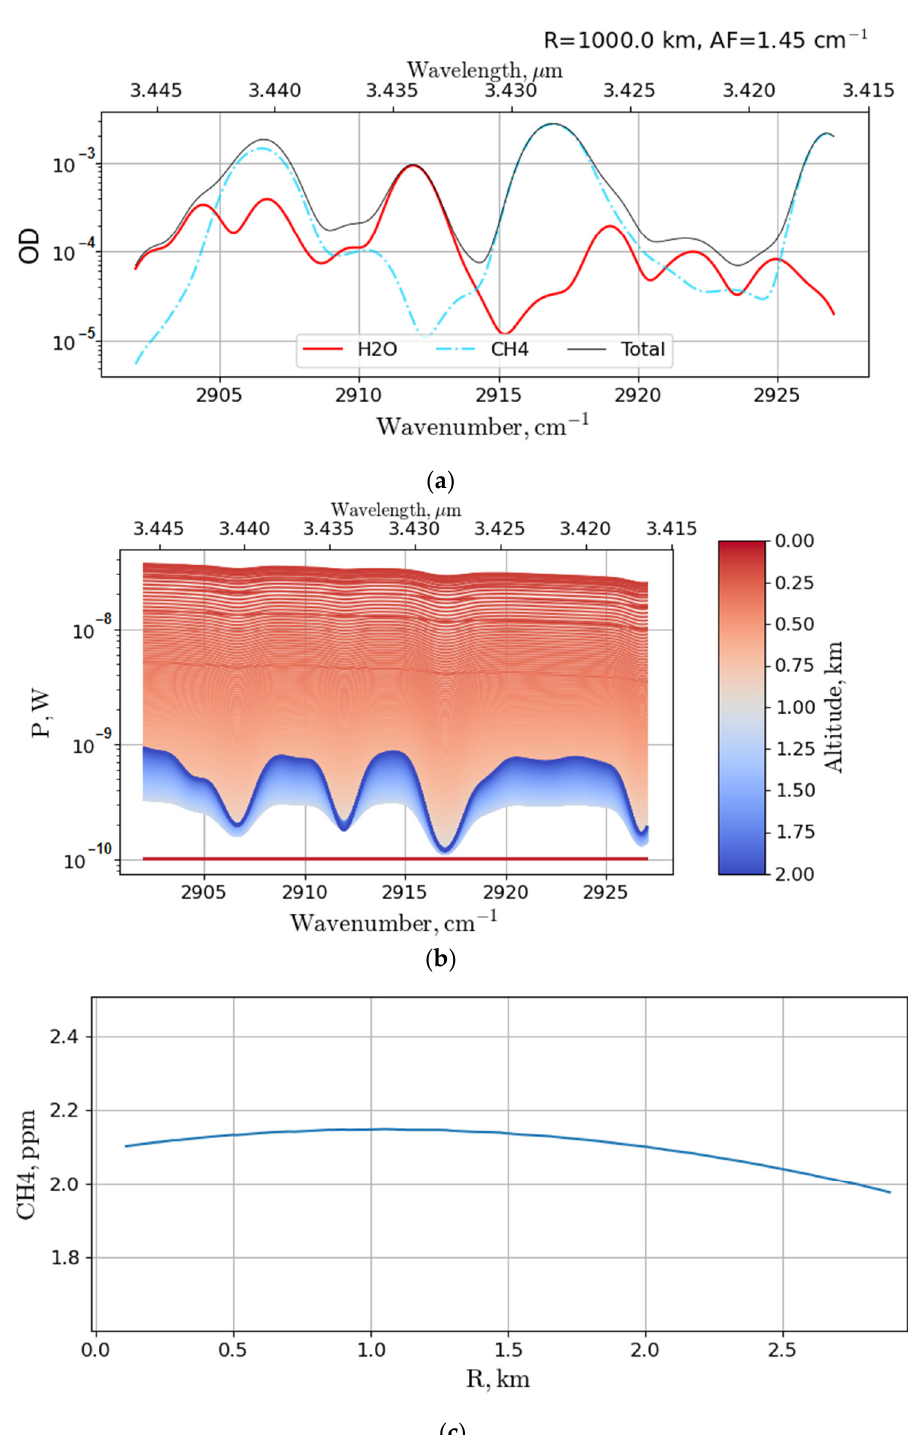
Figure 10. ( a ) Atmospheric optical depth (OD) in the methane sounding informative range; ( b ) lidar signals (P, W); ( c ) spatial distribution of methane content retrieved from the numerical experiment with the atmospheric model of midlatitude summer.